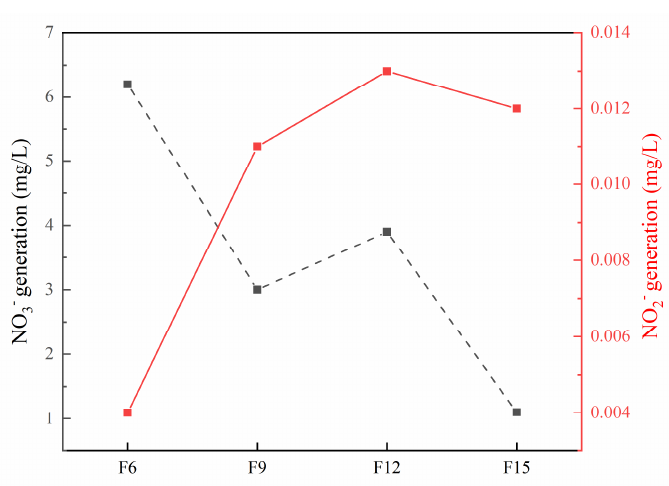
Figure 12. NO 3 − and NO 2 − production after the Figure 12. NO 3− and NO 2− production after the reaction.